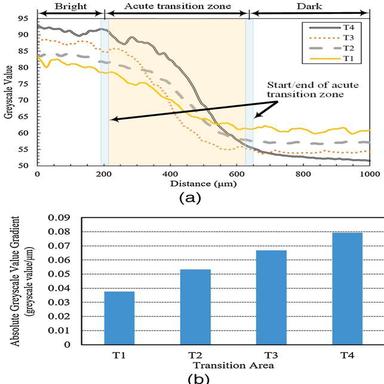
Greyscale values takes from different transition zones of the FGM: (a) Greyscale values at the transition zones of the bar sample with 2 mm thickness, (b) Absolute greyscale gradient values in transition zones.